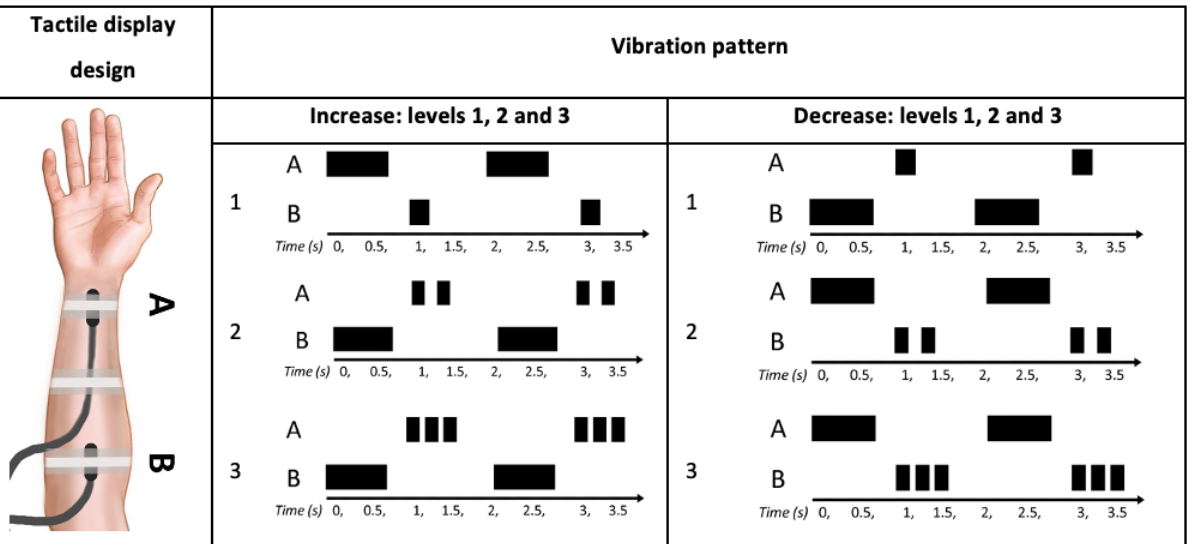
Figure 6. Tactile display on the forearm containing 2 tactors (A and B). The prototype was intended to monitor a single variable with 6 distinct vibration patterns: 3 to represent different levels of increase and 3 to represent different levels of decrease in the monitored variable. The black-block pattern indicates the tactile at that location is activated at that point in time. Note that the increase and decrease patterns are the same except that the A and B sites are interchanged (a model of the concept presented in the